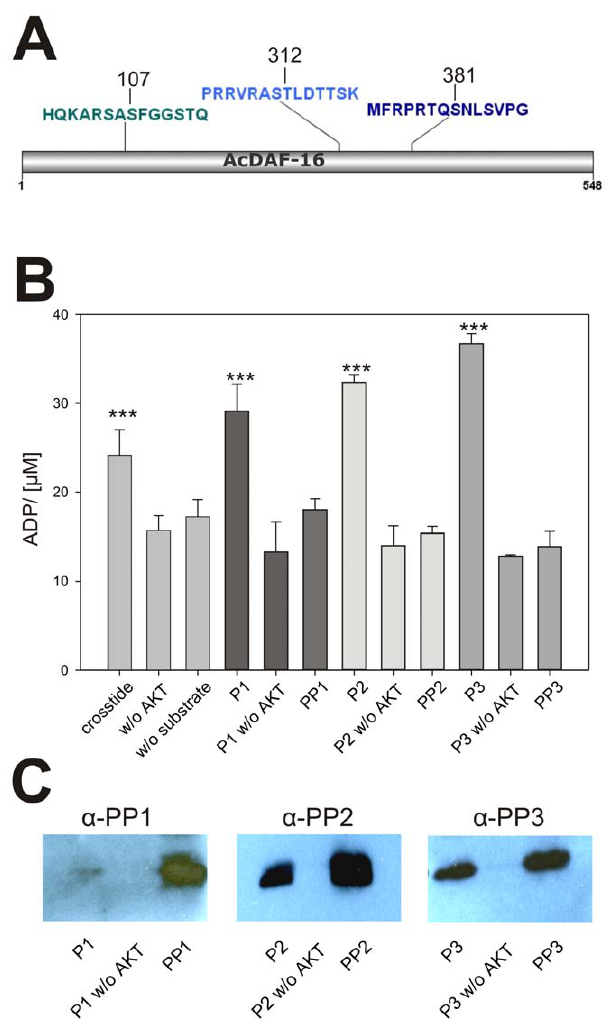
Figure 1. AKT phosphorylates Ac -DAF-16 on conserved phos- phorylation sites. A ) Graphical scheme of Ac -DAF-16 indicating the localization of the predicted AKT phosphorylation sites at position S107, T312 and T381 and the peptides (P1, P2, P3) of 15 amino acids lengths used in the in vitro phosphorylation assay. B ) In vitro phosphorylation assay of Ac -DAF-16 peptides by AKT. The means 6 SD of the ADP concentration after incubation of rAKT with the Ac -DAF-16 peptides in the presence of ATP is shown. Crosstide was used as a control substrate. Negative controls were reactions without AKT as well as phospho- peptides (PP1, PP2, PP3) containing the phosphorylated residue of interest. The experiments were repeated three times. Asterisks represent p- values , 0.05 in T-tests between the sample versus controls. C ) Reactions from the in vitro phosphorylation assay were separated by PAGE and blotted on nitrocellulose membrane. Proteins were detected by phospho-specific peptide antibodies as described.